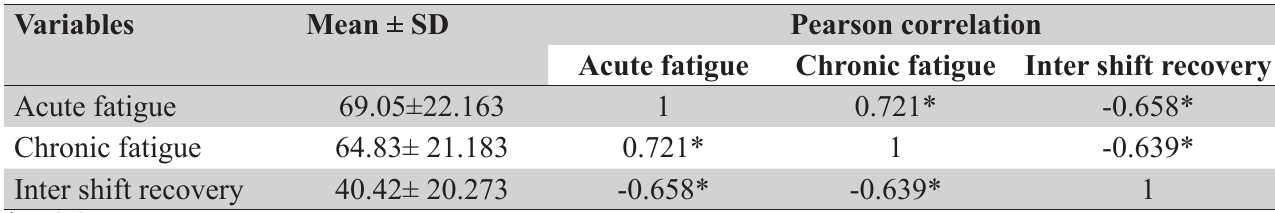
Table 2: Correlation among acute fatigue, chronic fatigue and inter shift recovery of the participants (n=151).